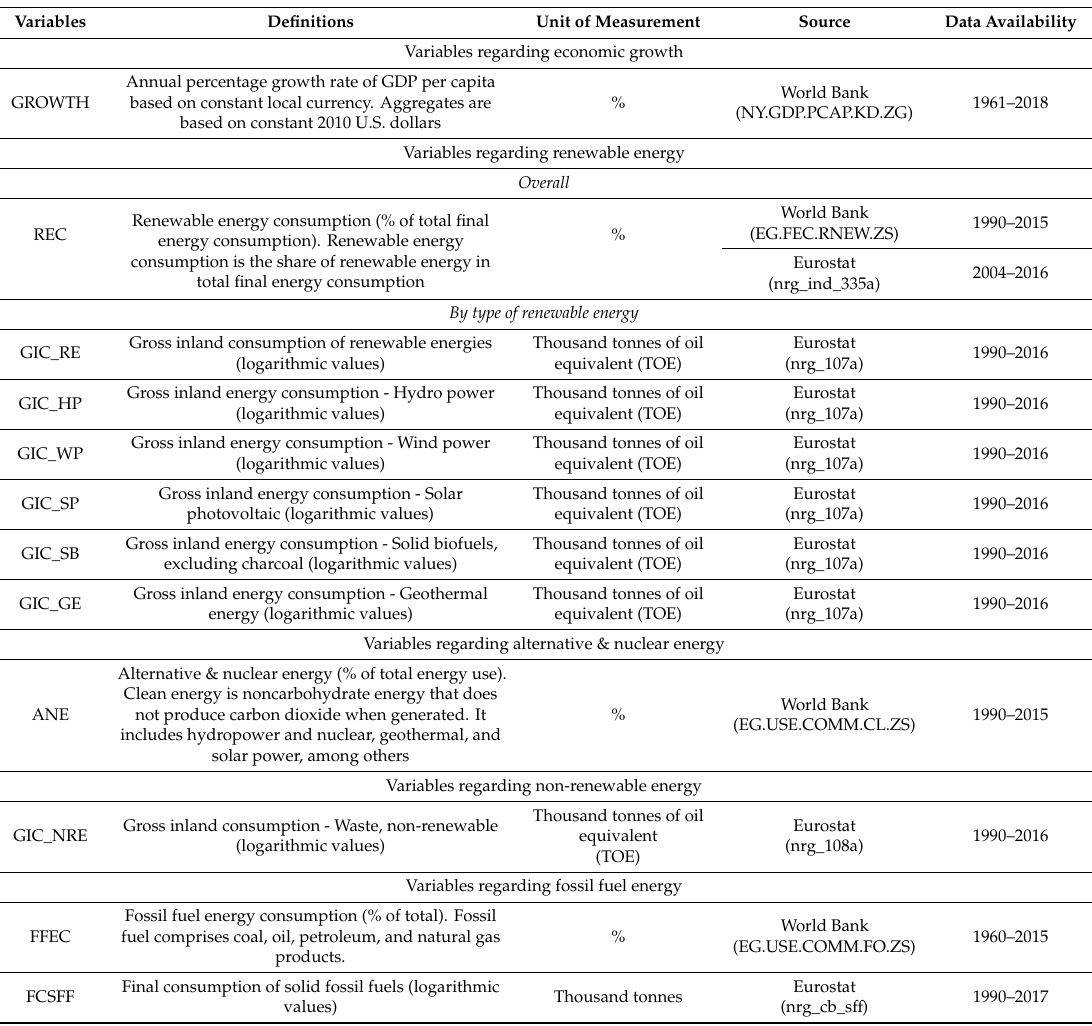
Table 2. Variables’